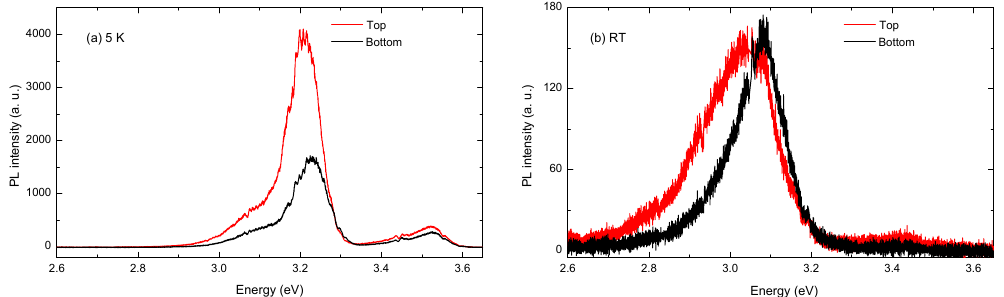
Figure 6. Representative photoluminescence (PL) spectra taken at the top (red line) and at the bottom (black line) of the NWs ( a ) at liquid He and ( b ) room temperature.